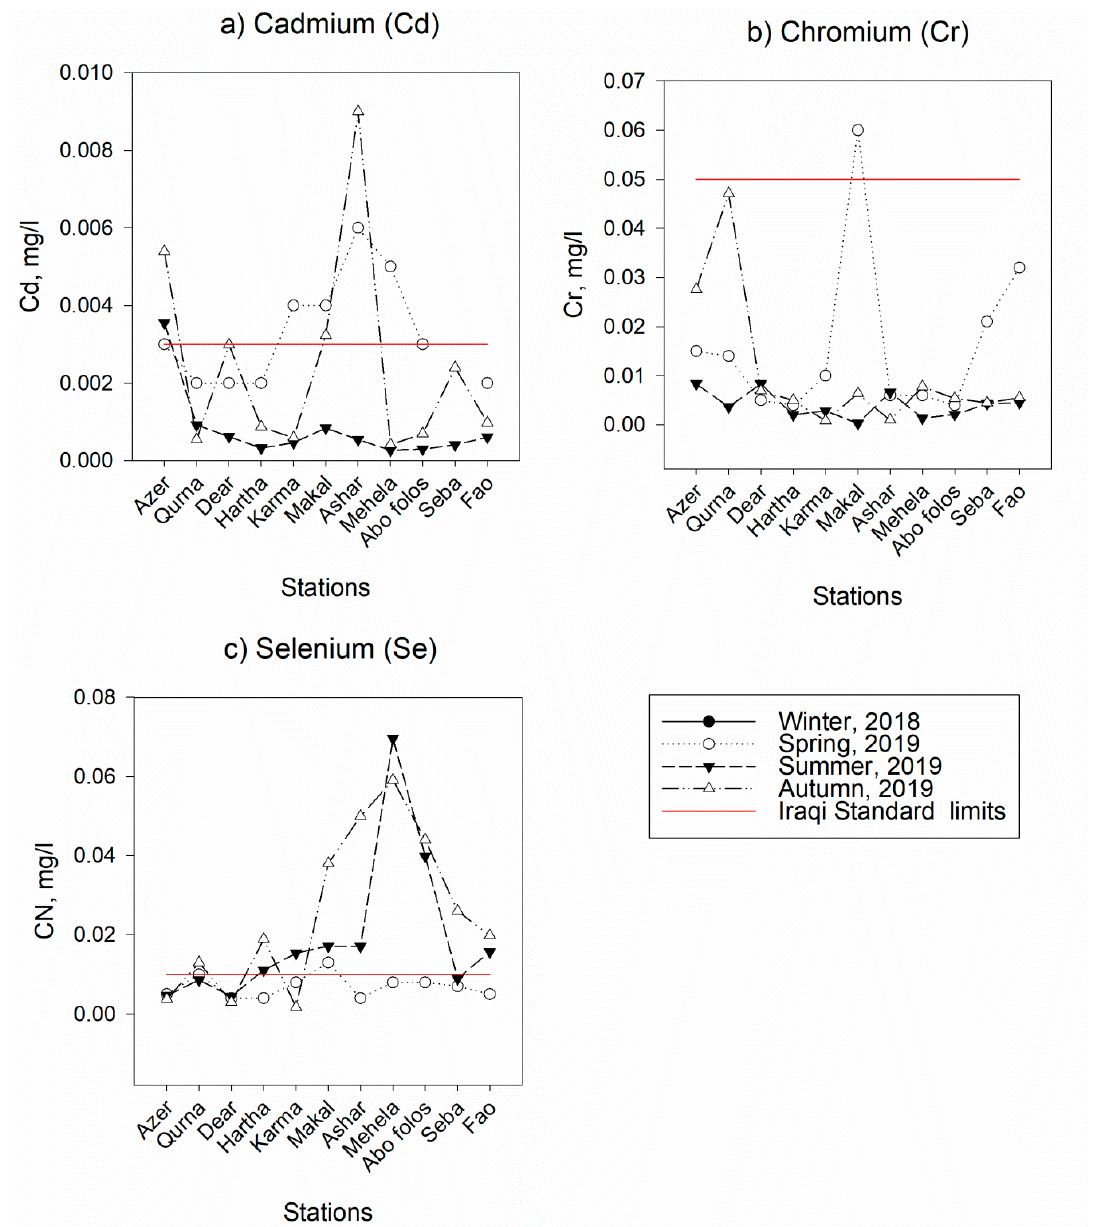
Figure 13. Heavy Metals concentrations of the selected stations for different seasons during the study period: ( a ) Cadmium, ( b ) Chromium, and ( c ) Selenium.